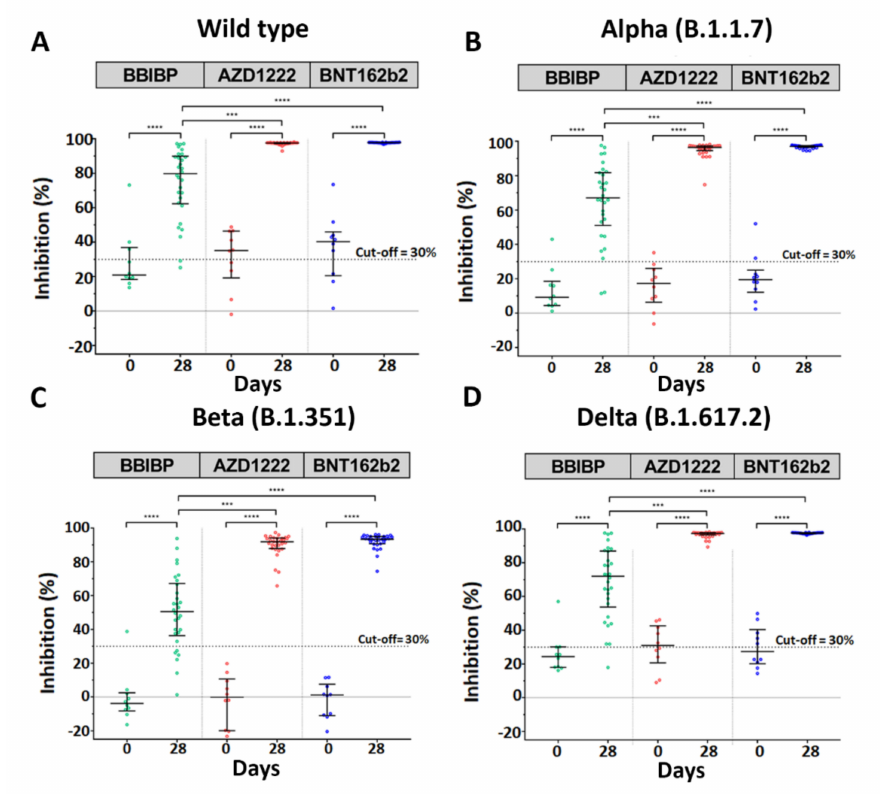
Figure 3. Neutralization activities against wild-type and SARS-CoV-2 variants measured by surro- gate virus neutralization test (sVNT). The serum samples obtained from participants who received two completed doses of the inactivated vaccine, CoronaVac; followed by the inactivated vaccine, BBIBP (green); the viral vector vaccine, AZD1222 (red); or the mRNA vaccine, BNT162b2 (blue), at 3–4 months after the first dose were compared. The neutralizing activities against SARS-CoV-2 Wide- type ( A ), Alpha (B.1.1.7) ( B ), Beta (B.1.351) ( C ), and Delta (B.1.617.2) ( D ) were shown. Lines represent medians with interquartile ranges (IQR); ns indicates no significant difference; p -value < 0.001 (***), 0.0001 (****).